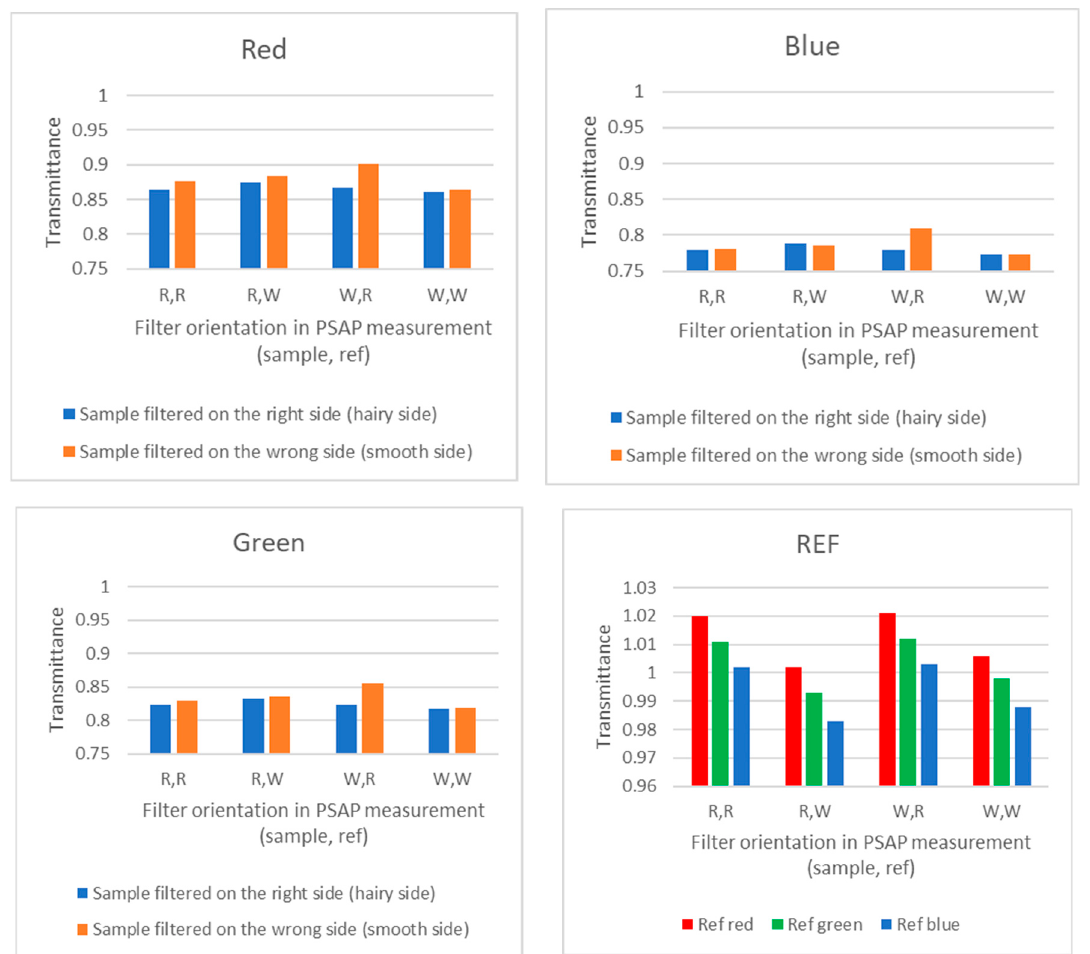
Figure 5. Results from the “wrong-side-up filter” test using a particle soot absorption photometer PSAP.